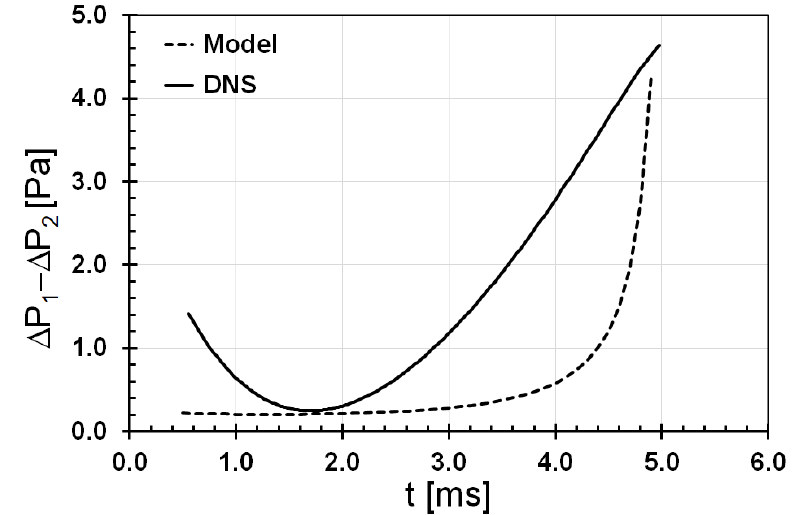
Figure A1. Comparison of the difference between the pressure differences acting across the leading and trailing droplets, ∆ P 1 − ∆ P 2 in the current analysis (using Equations (4) and (7)) with the corresponding data from direct numerical simulation (DNS). The initial conditions are the same as given in Figure 2 for both the analytical predictions and the DNS. Please note that in DNS, an infinite single stream of droplets is